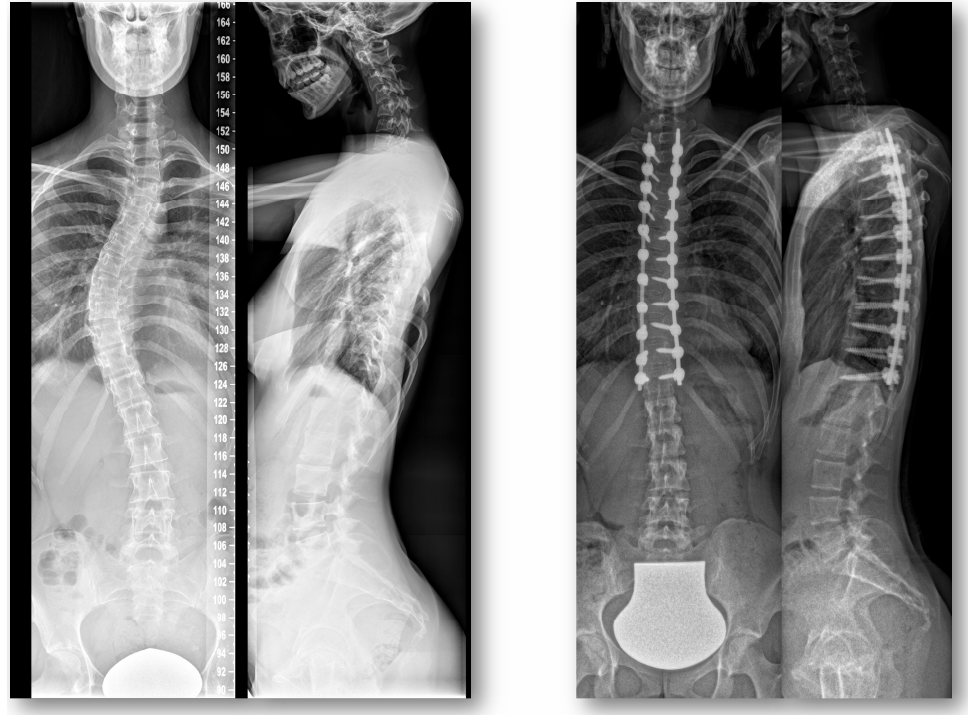
Figure 3. Pre-operative and post-operative coronal and lateral radiographs of study patients with adolescent idiopathic scoliosis and posterior